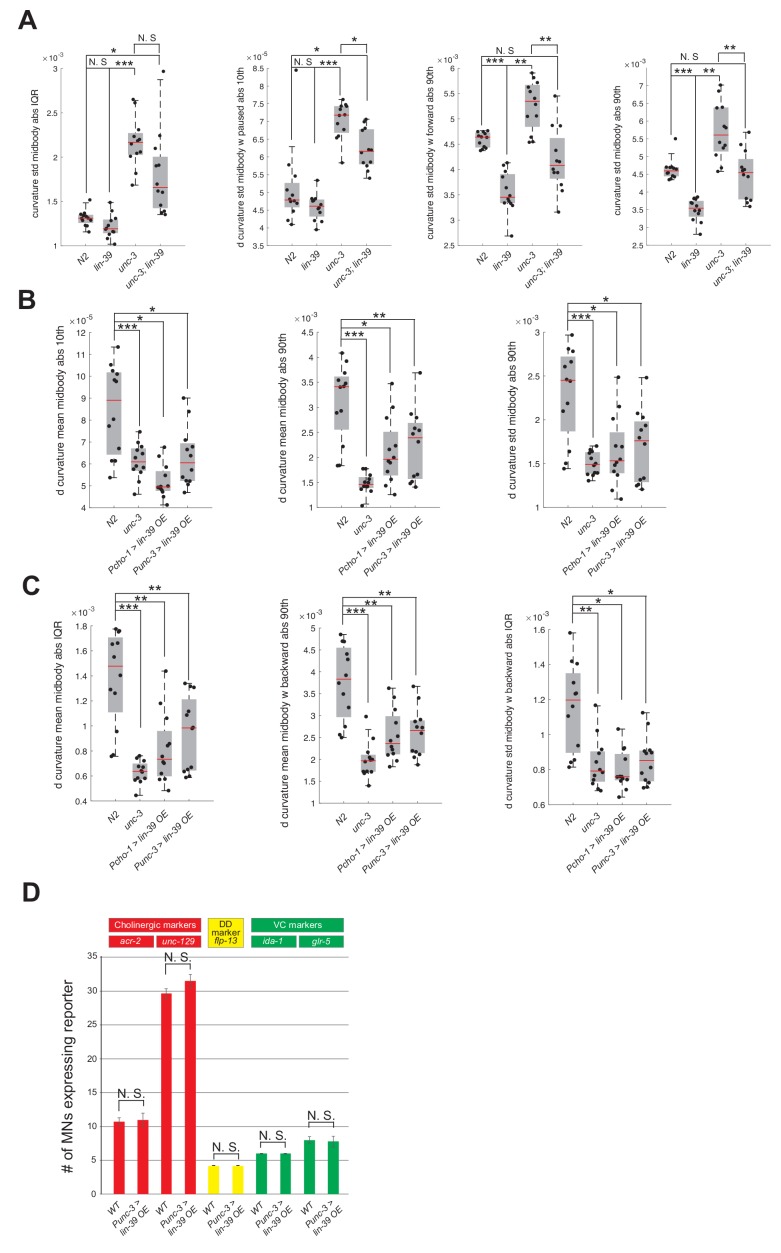
Automated worm tracking analysis on unc-3 and unc-3; lin-39 mutants.(A) Additional mid-body locomotion features that are significantly affected in unc-3 (n3435) animals, but markedly improved in unc-3 (n3435); lin-39 (n1760) double mutant animals. Each black dot represents a single adult animal. The unit for the first two graphs is 1/microns. The unit for the graph on the right is 1/(microns*seconds). N = 12. For a comprehensive list of mid-body features see Supplementary file 3. *p<0.01, **p<0.001, ***p<0.0001. (B–C) Additional mid-body locomotion features affected in unc-3 (n3435) mutants and animals over-expressing lin-39 in cholinergic MNs. Each black dot represents a single adult animal. The unit for the y axis is 1/(microns*seconds). N = 12. For a comprehensive list of mid-body features see Supplementary file 3. *p<0.01, **p<0.001, ***p<0.0001. (D) Over-expression of LIN-39 in cholinergic MNs (Punc-3 >LIN-39 OE) does not affect expression of terminal identity genes specific to cholinergic (acr-2, unc-129), GABAergic DD (flp-13) or VC (ida-1, glr-5) motor neurons. L4 stage animals were imaged and quantified. N > 15.